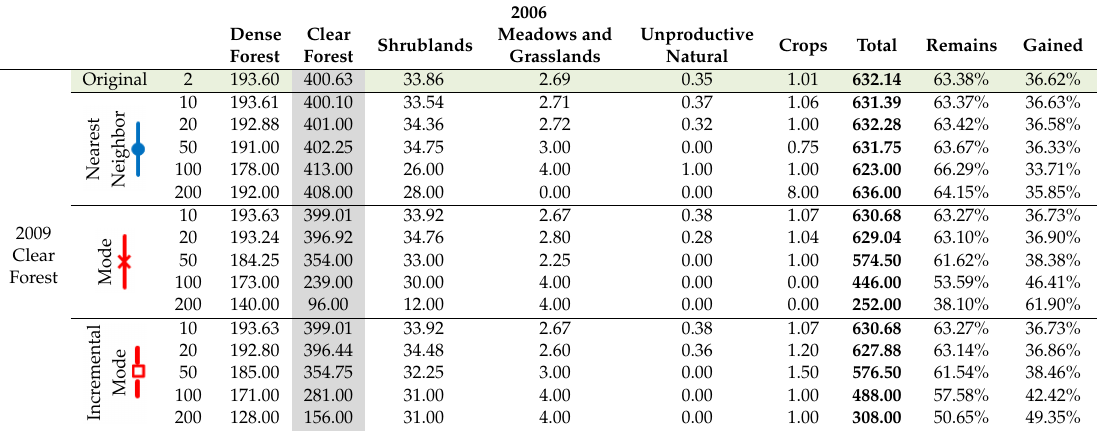
Table 6. Distribution of 2009 Clear Forest (rows) in 2006 categories (columns) in the Mass í s del Montseny protected area (in ha). Original resolution and resampled resolutions using di ff erent methods are shown. Original resolution is the green shadowed row (and corresponds to the green shadowed row in Table 5). 2006 Dense